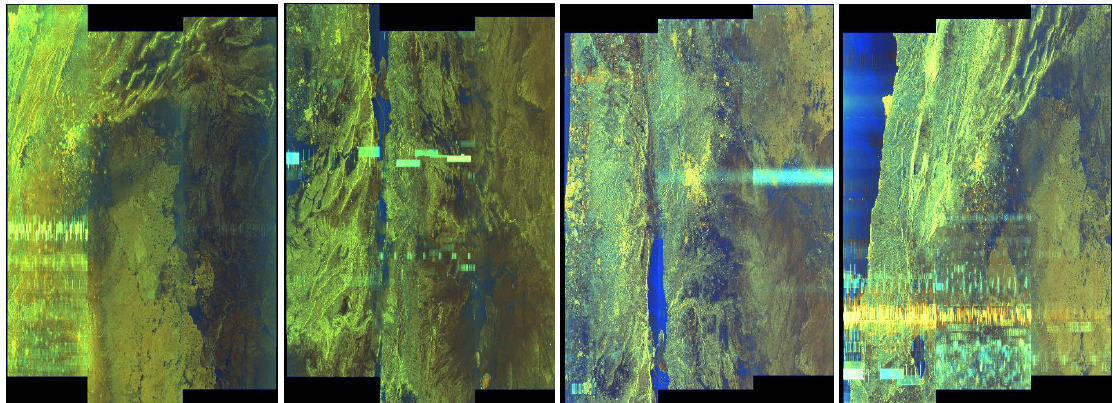
Figure 1. Example of results that contain radio-frequency interference (RFI)